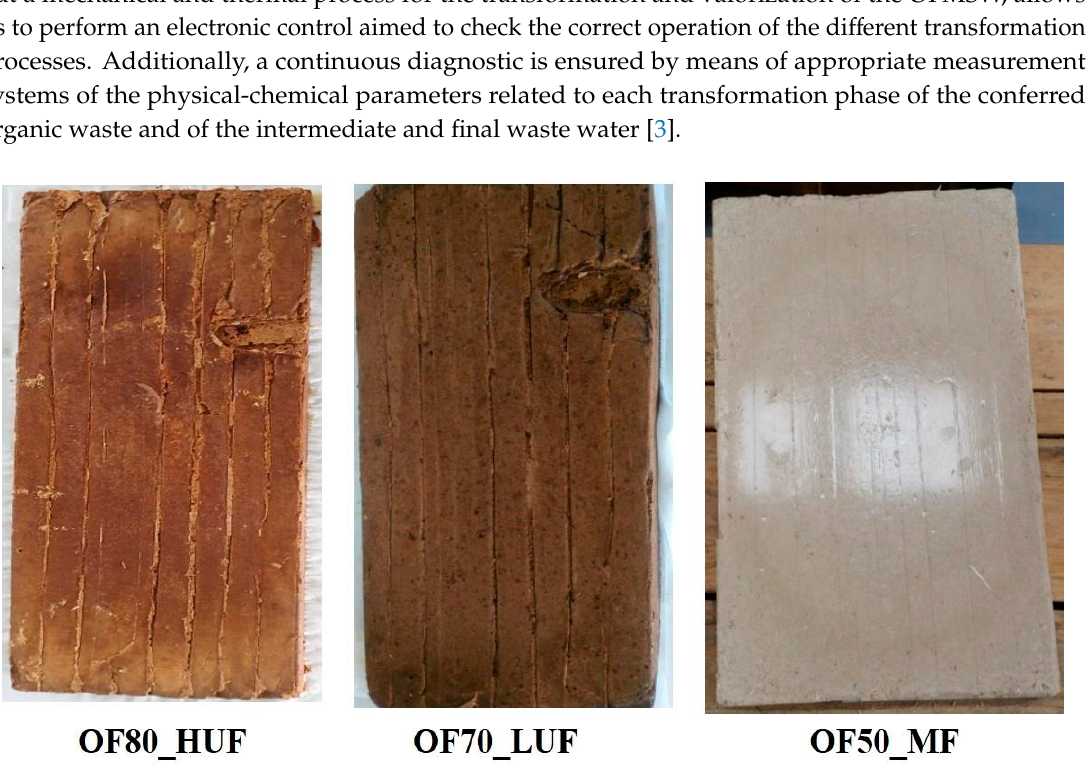
Figure 1. OFMSW-based panel production with different resins.